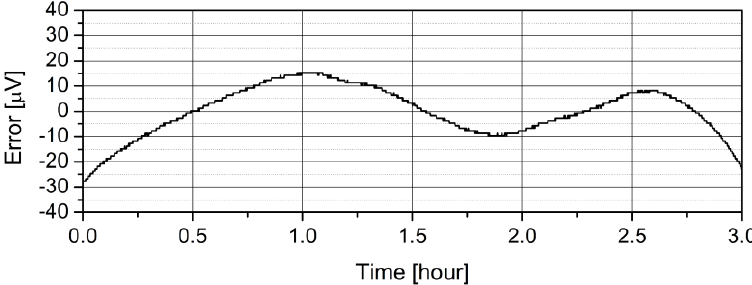
Figure 6. Voltage error vs. time in stabilized state of voltage source with the 2SK3557-6 JFET follower.